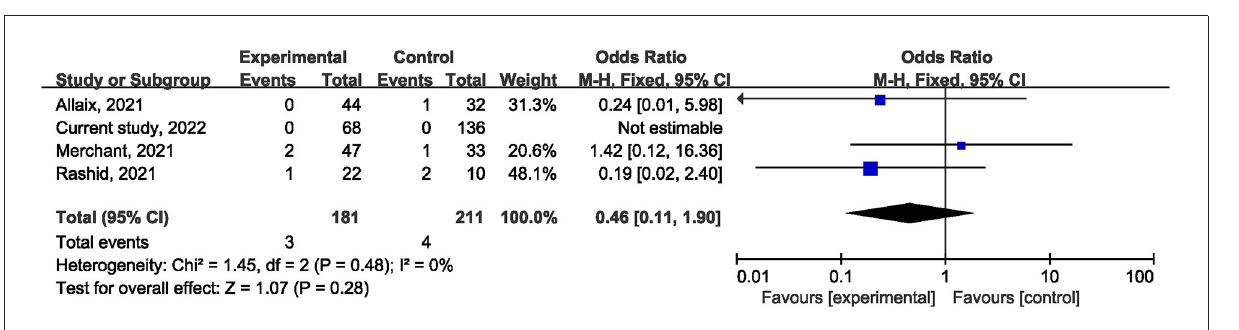
FIGURE6 The impact of the COVID-19 pandemic on the R1 resections rate.